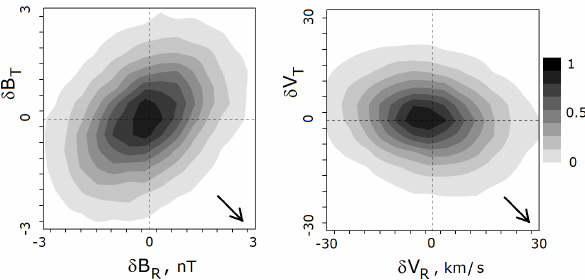
Figure 5. 2D distribution of radial δB R and tangential δB T compo- nents of magnetic fluctuations ( left panel ) and distribution of radial δV R and tangential δV T components of velocity fluctuations ( right panel ). Arrow indicates approximate direction of mean magnetic